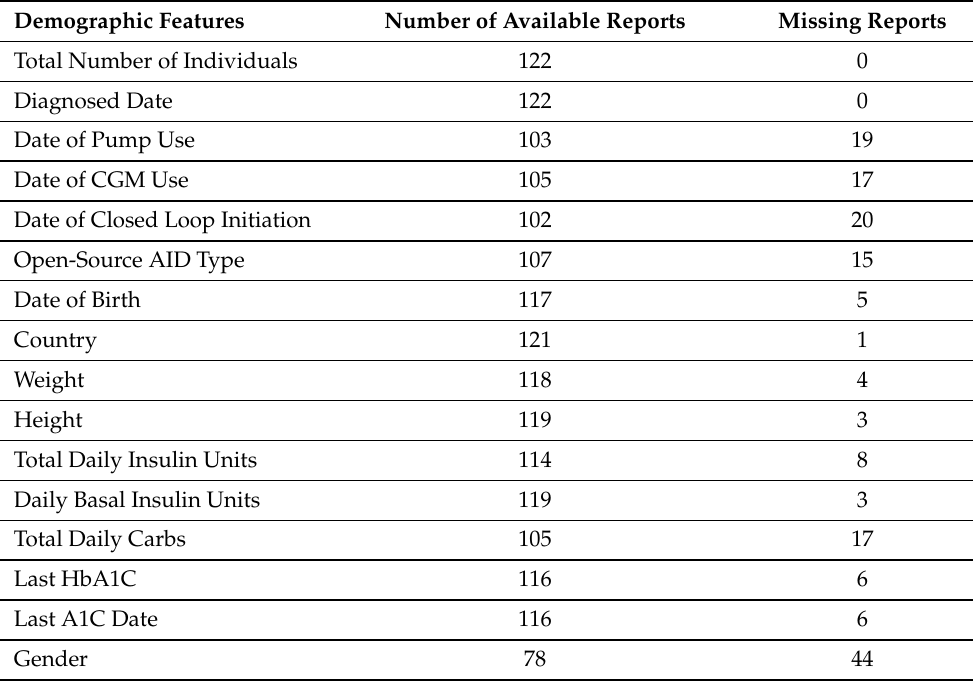
Table 2. Count of self-reported demographics